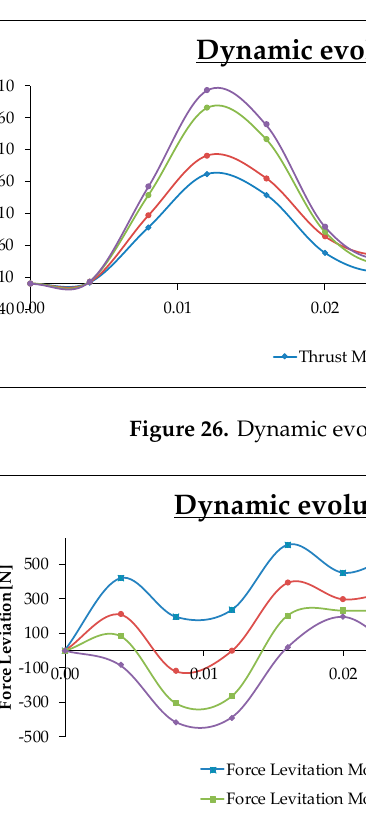
Figure 27. Dynamic evolution of the levitation force in each model.